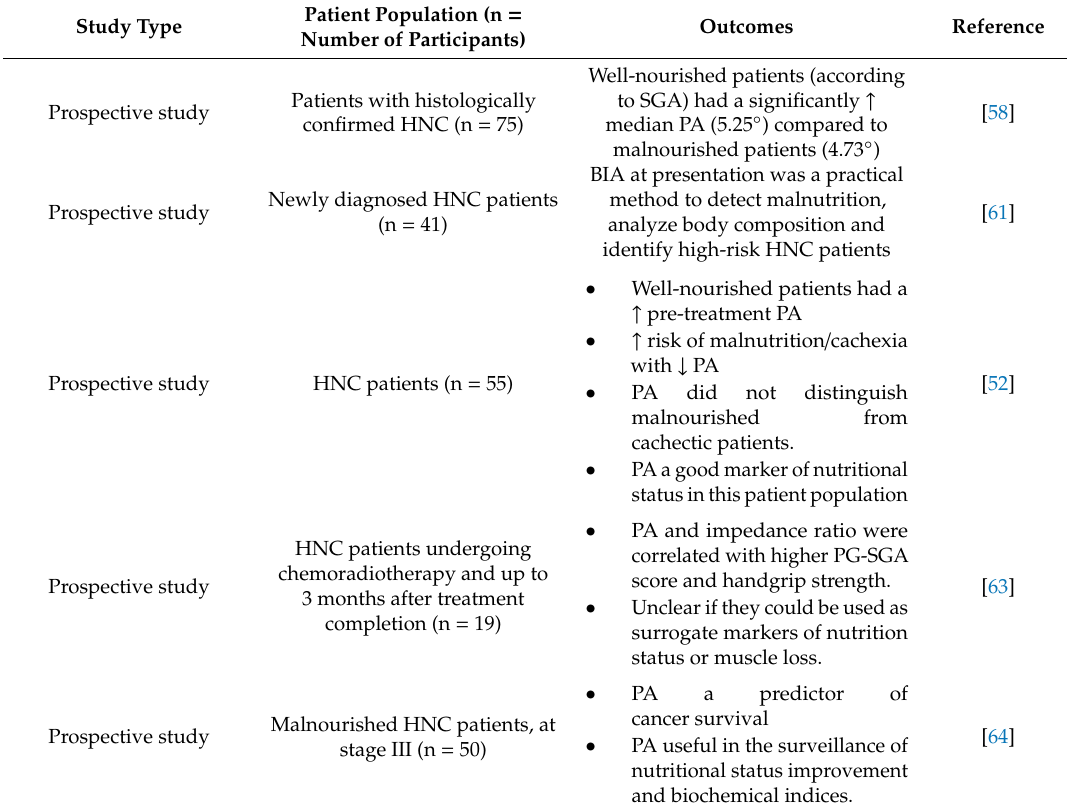
Table 3. Studies examining the role of tissue electrical properties on identifying